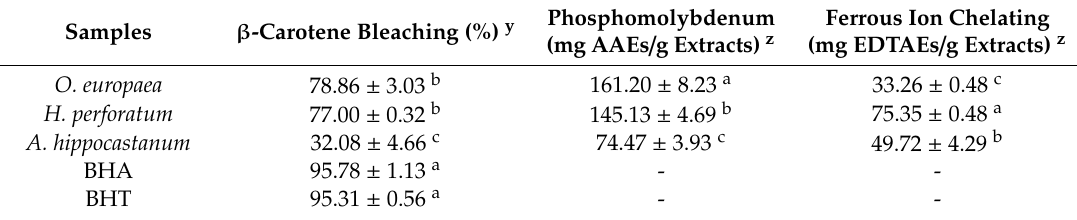
Table 3. Ferrous ion chelating, phosphomolybdenum, and β -carotene bleaching activities of the water extracts from plants x .